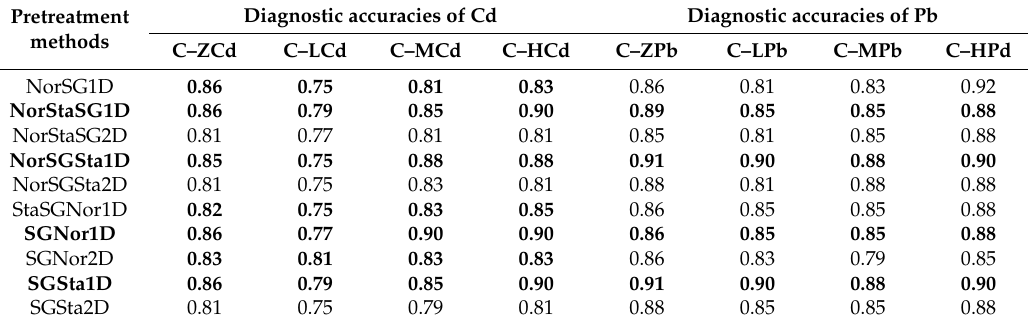
Table 4. Diagnostic accuracies for Cd–Pb cross-stress with di ff erent pretreatment